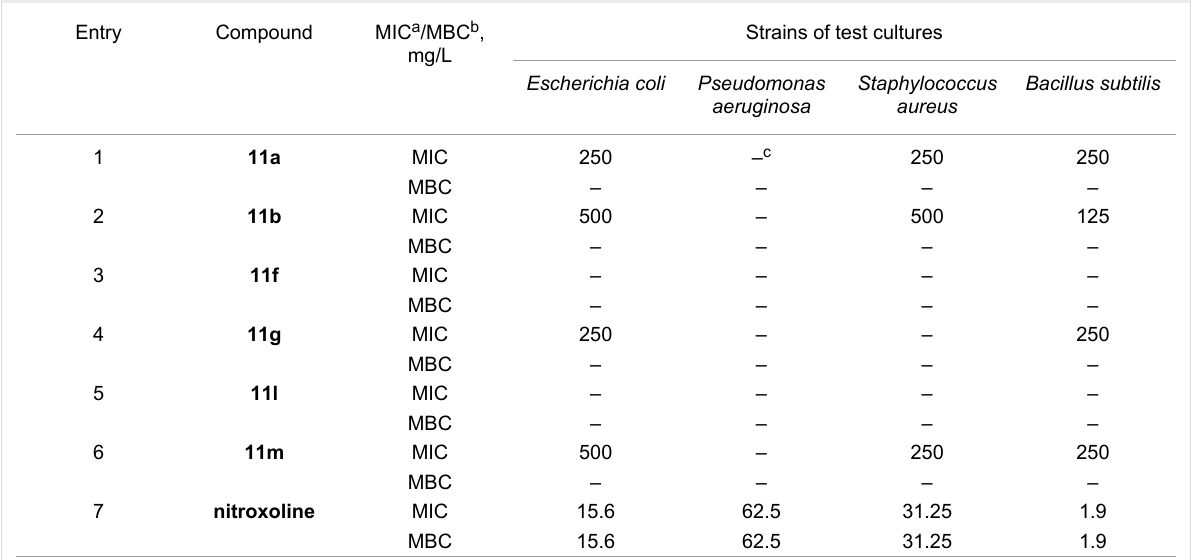
Table 2: Antibacterial activity